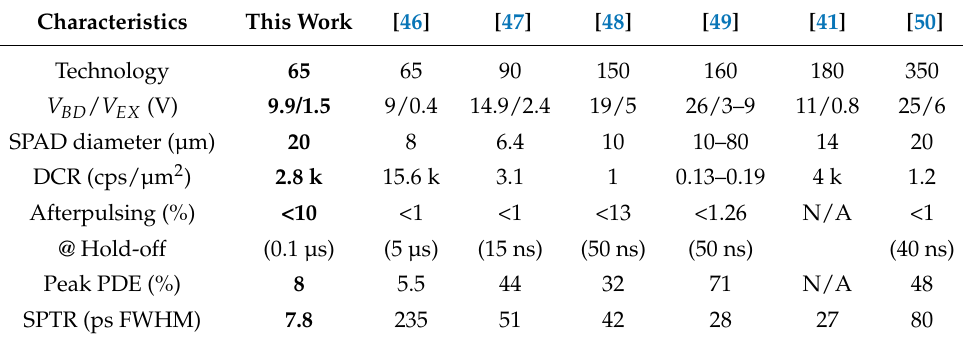
Table 1. SPAD characteristics